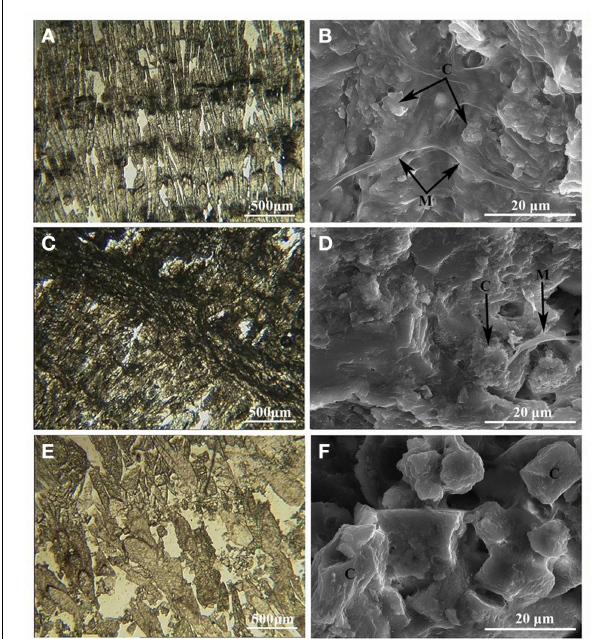
FIGURE 2 | Polarized light (one polarizer) microphotos of carbonate crusts (A,C,E) and SEM detail view of intermediate dark layers (B,D,F). (A) 32 ◦ C carbonate deposit (sample C32) displaying a laminated pattern of crystals arranged in a succession of lighter and darker laminae. (B) Detailed view of the darker layer in C32 displaying a close association between the crystals and organic material. (C) 49 ◦ C carbonate deposit (sample C49) where the dark laminae are found between well-defined layers of crystallized calcite. (D) Detailed view of the darker layer in C49 displaying a close association between the crystals and organic material. (E) 65 ◦ C carbonate deposit (sample C65) displaying a more irregular pattern of crystal growth with no intermediate black layers. (F) Detailed view of sample C65, showing carbonate crystals without an association with a well-defined microbial mat. M: microbial cells embedded in EPS; C, carbonate